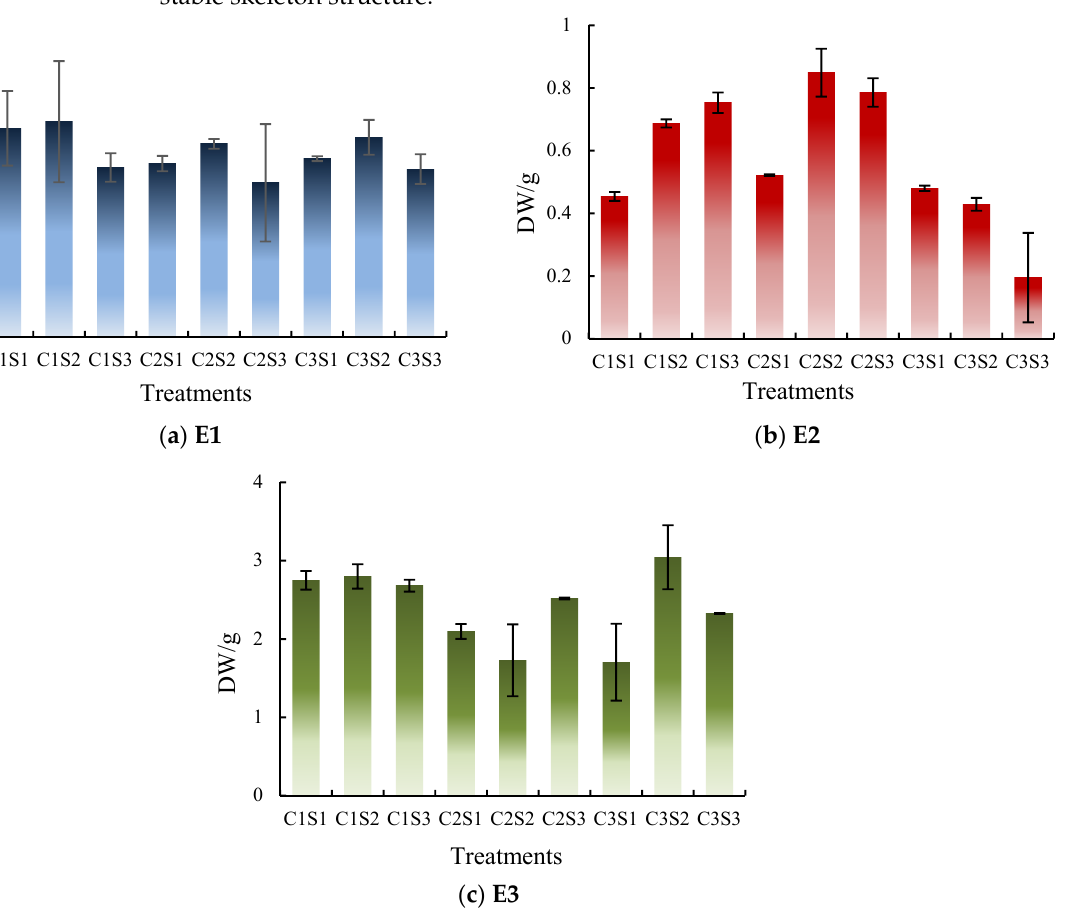
Figure 6. Dry weight of clogging in emitters under different treatments. ( a ) Dry weight of clogging in E1. ( b ) Dry weight of clogging in E2. ( c ) Dry weight of clogging in E3.